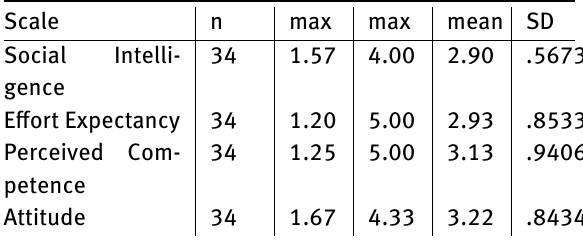
Table 9: Number of participants, minimum, maximum, mean, and the standard deviation of the score for each scale of the SoAc- Questionnaire.